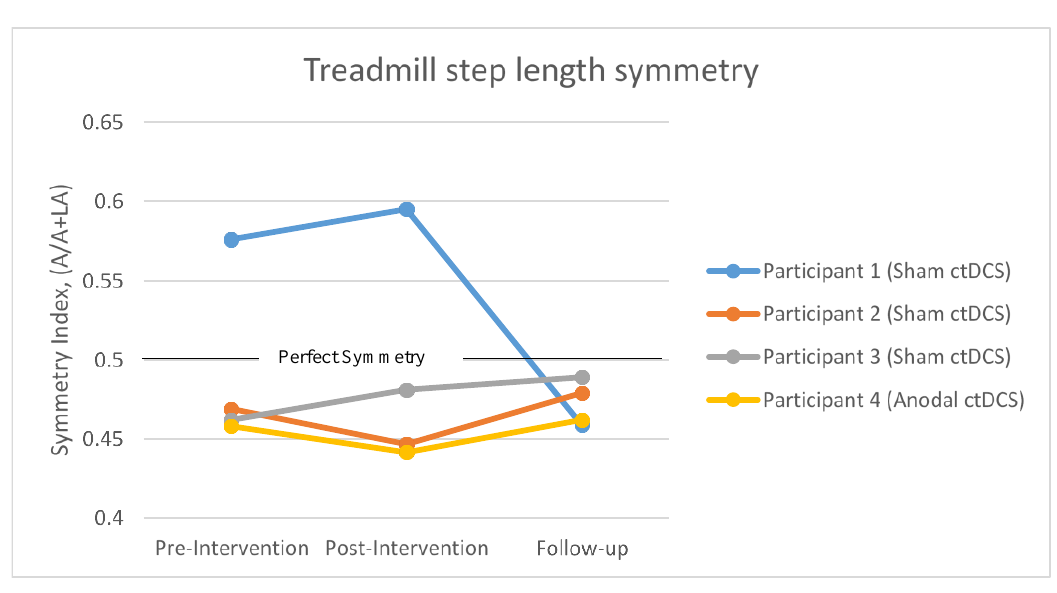
Figure 5. Mean treadmill step length symmetry at pre-intervention, post-intervention and follow-up assessment. The black horizontal line represents perfect symmetry. A: a ff ected step length, LA: less-a ff ected step length.